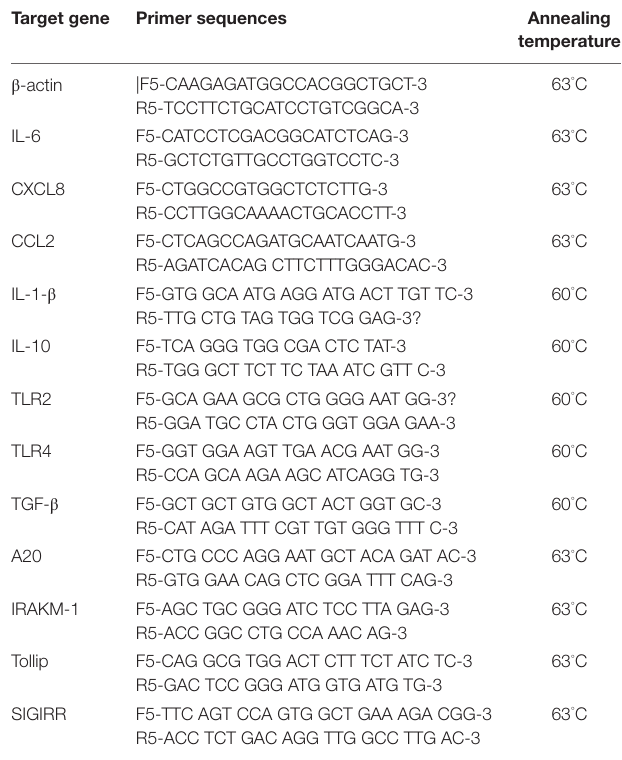
TaBle 1 | List of primers used in this study for